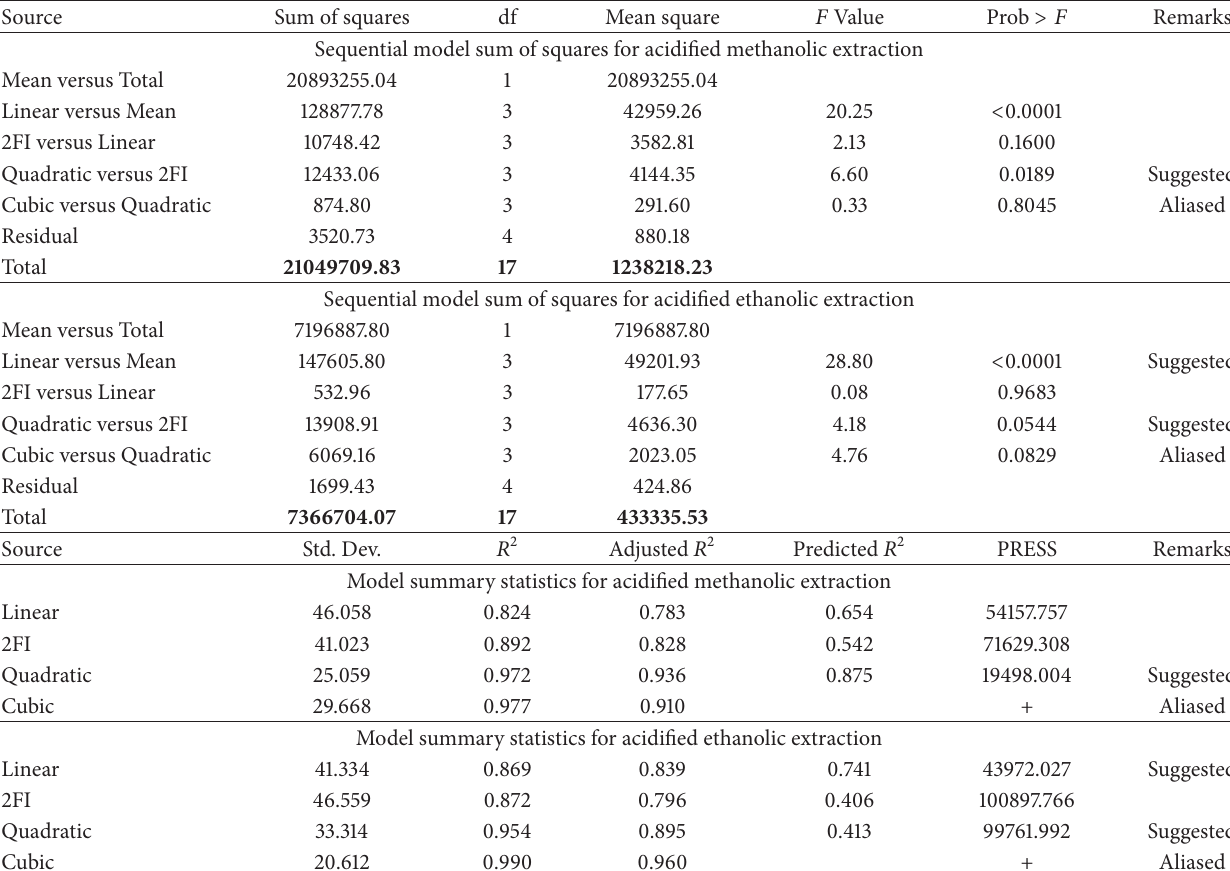
Table 2: Adequecy of model